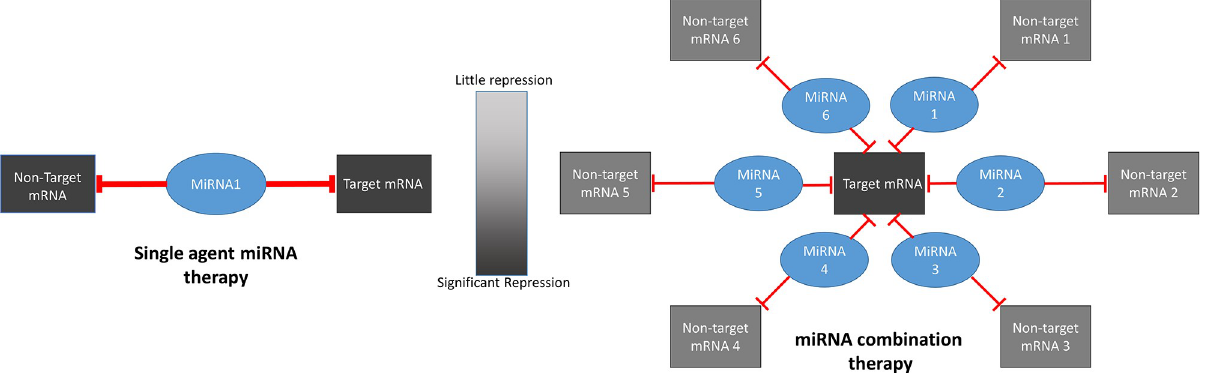
Fig 1. Cartoon describing rationale for focusing on miRNA combination therapy. With single-agent therapy, both target mRNA and non-target mRNA are inhibited an equal amount, potentially resulting in toxicity due to off-target effects. With miRNA combination therapy, the common target mRNA is inhibited to a greater degree than any individual non-target